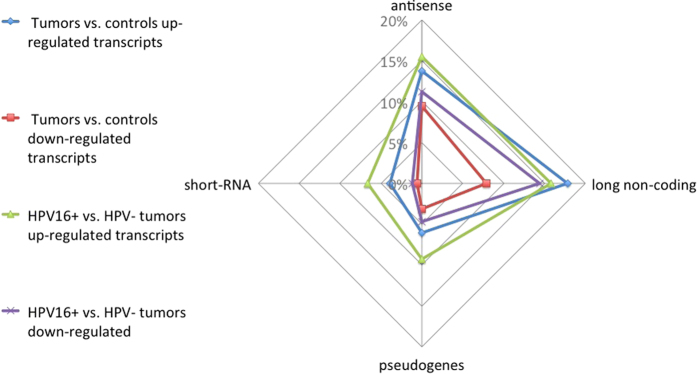
Proportions of differentially expressed ncRNA by biotype in tumours versus normal and HPV16+ versus HPV− comparisons. Here we separated differentially expressed (DE) genes into two categories: (1) commonly up- and downregulated genes between cases and controls (shown in intersections on Figure 1) independent of HPV status, denoted ‘tumours vs controls’; (2) remaining DE genes specific to HPV16 status, called ‘HPV16+ vs HPV− ’ DE genes (see Materials and Methods). In this diagram, 100% corresponds to the total number of DE annotated genes per comparison, including coding genes. Only non-coding gene proportions are shown here. Pseudogenes, antisense RNA, and short RNA appear to be more up-regulated in HPV16+ tumours compared with HPV− tumours. The remaining long non-coding RNA types are more upregulated in tumours compared with controls, independent of HPV status. Overall, ncRNA is more often upregulated in tumours.